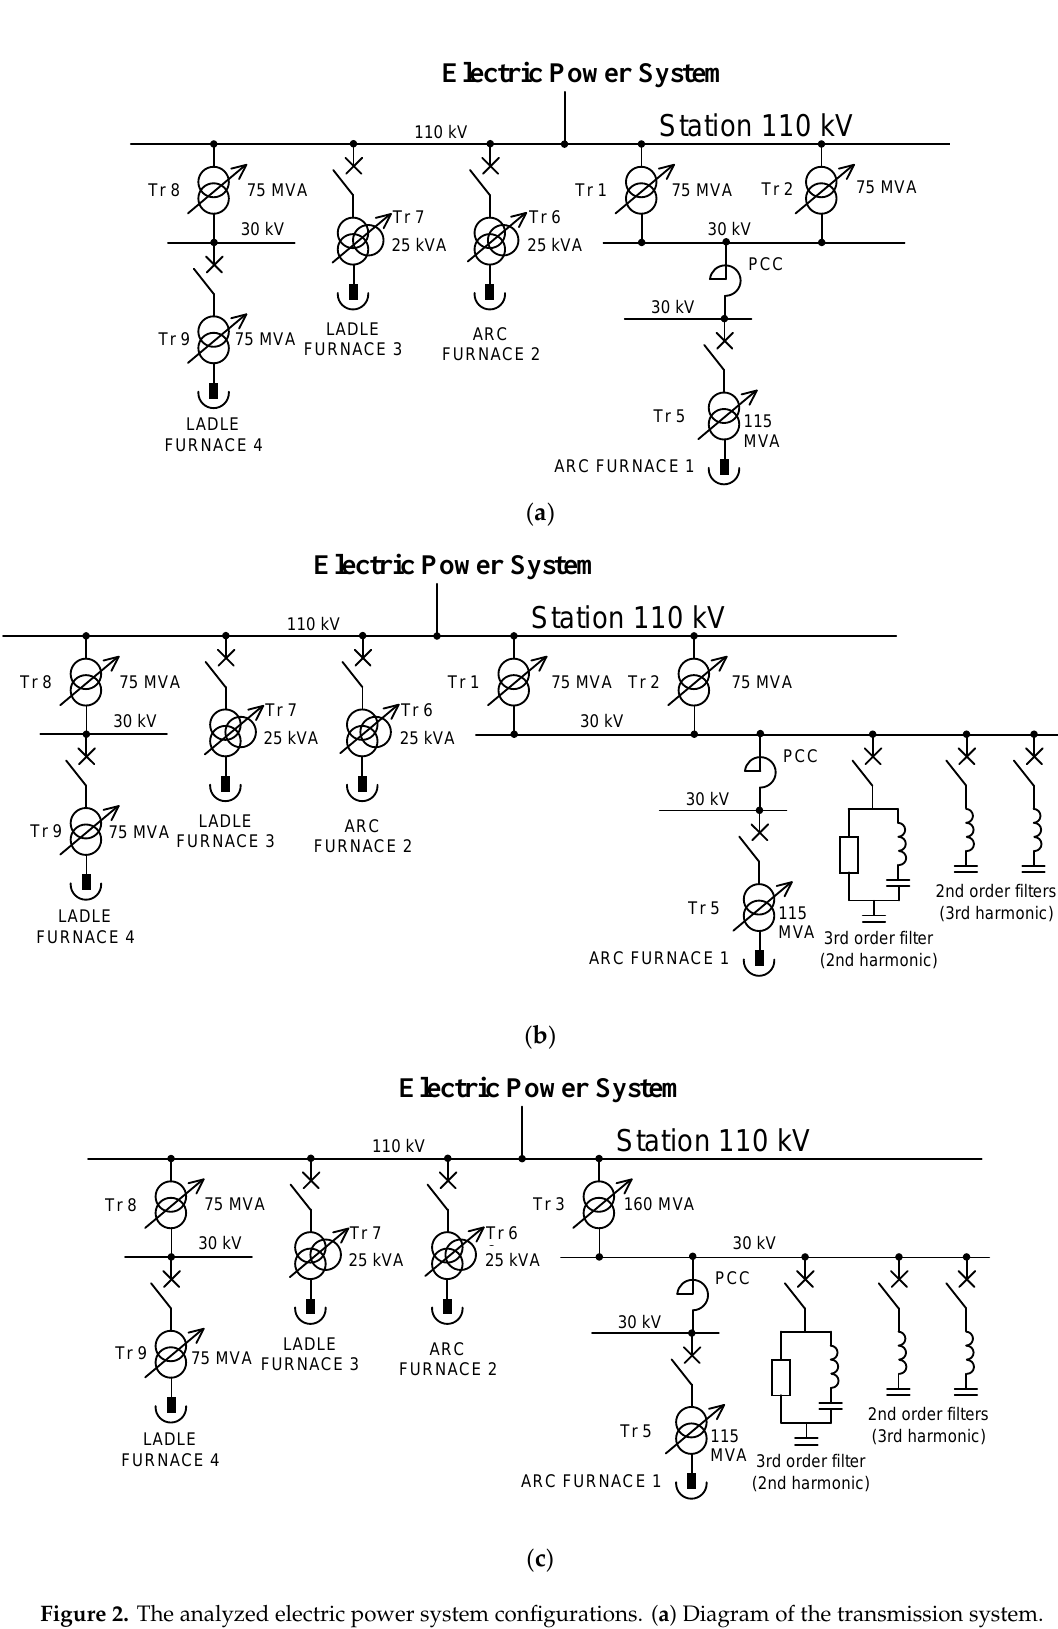
Figure 2. The analyzed electric power system configurations. ( a ) Diagram of the transmission system. ( b ) Diagram of a transmission system with reactive power compensation where higher harmonics are filtered by LC-type and C-type filters when arc furnace 1 is supplied by transformers Tr 1 and Tr 2. ( c ) Diagram of a transmission system with reactive power compensation where higher harmonics are filtered by LC-type and C-type filters when arc furnace 1 is supplied by transformer Tr 3.